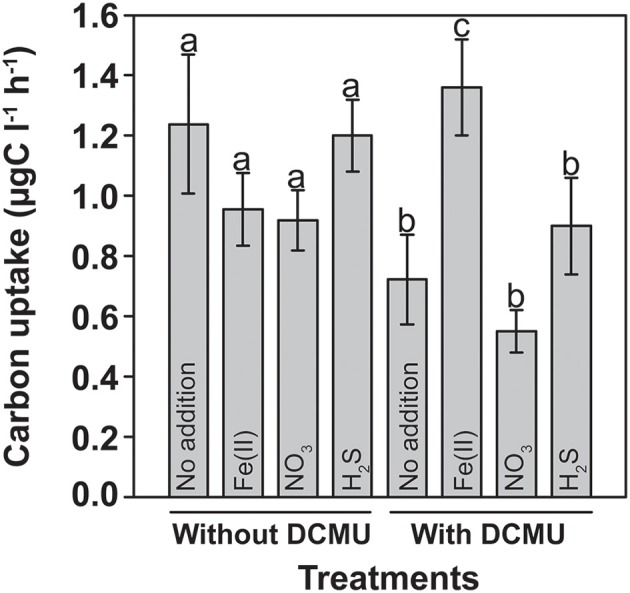
Light-dependent inorganic carbon uptake in presence of potential substrates for lithoautotrophic iron- and sulfur-transforming microorganisms. In-situ net photosynthetic carbon fixation experiments showing a statistically significant stimulation upon Fe(II) addition in presence of DCMU (-c-, p < 0.05) that inhibits oxygen production by photosynthesis. The net photosynthetic carbon uptake was obtained by subtracting the dark incubation values from the carbon uptake in the light. Letters represent the statistical groups using generalized linear models. Average values and standard deviations are presented (13/Oct/2008).